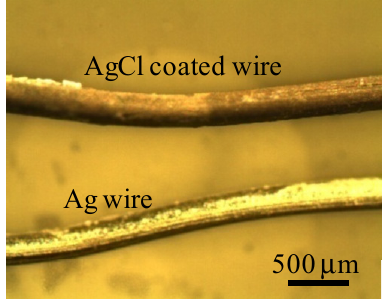
Figure 2. Photo of an Ag wire and an Ag wire coated with